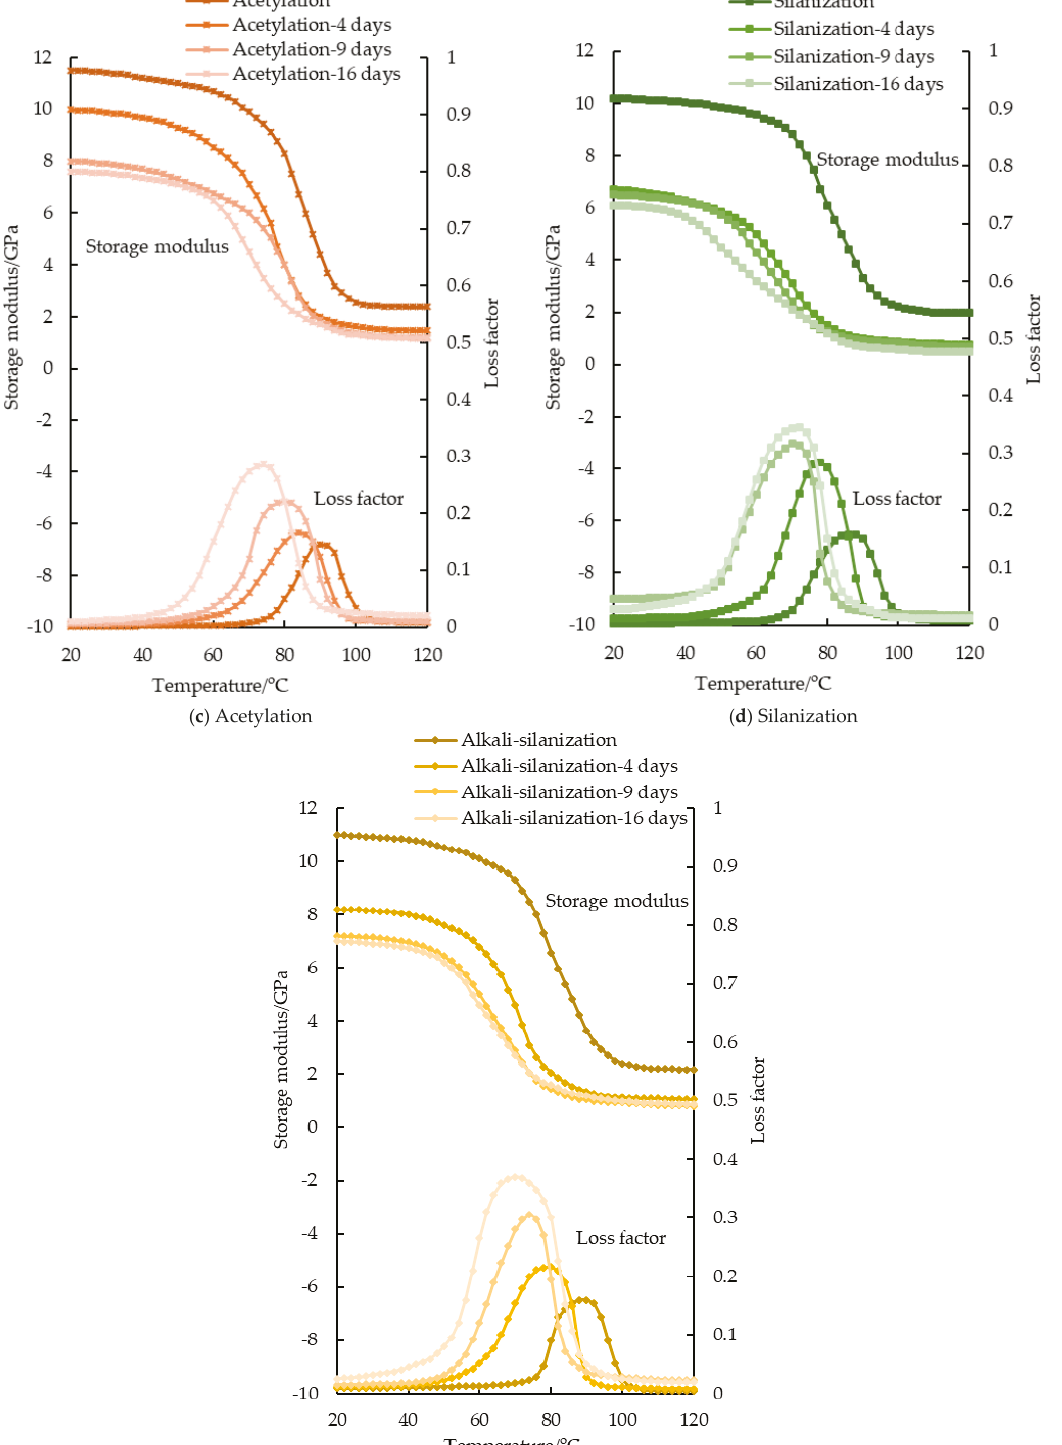
Figure 3. Storage modulus and loss factor of FFRP (Flax fiber Reinforced Polymer) after hygrothermal